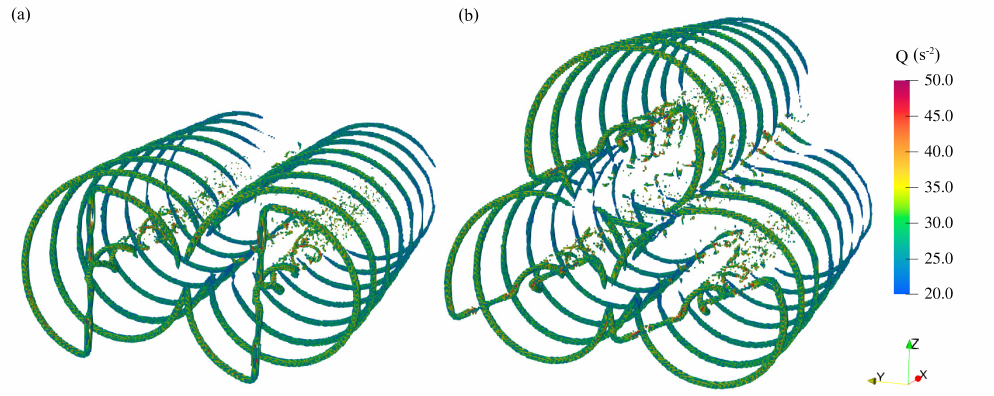
Figure 6. Near-wake: ( a ) Twin-rotors; and ( b )